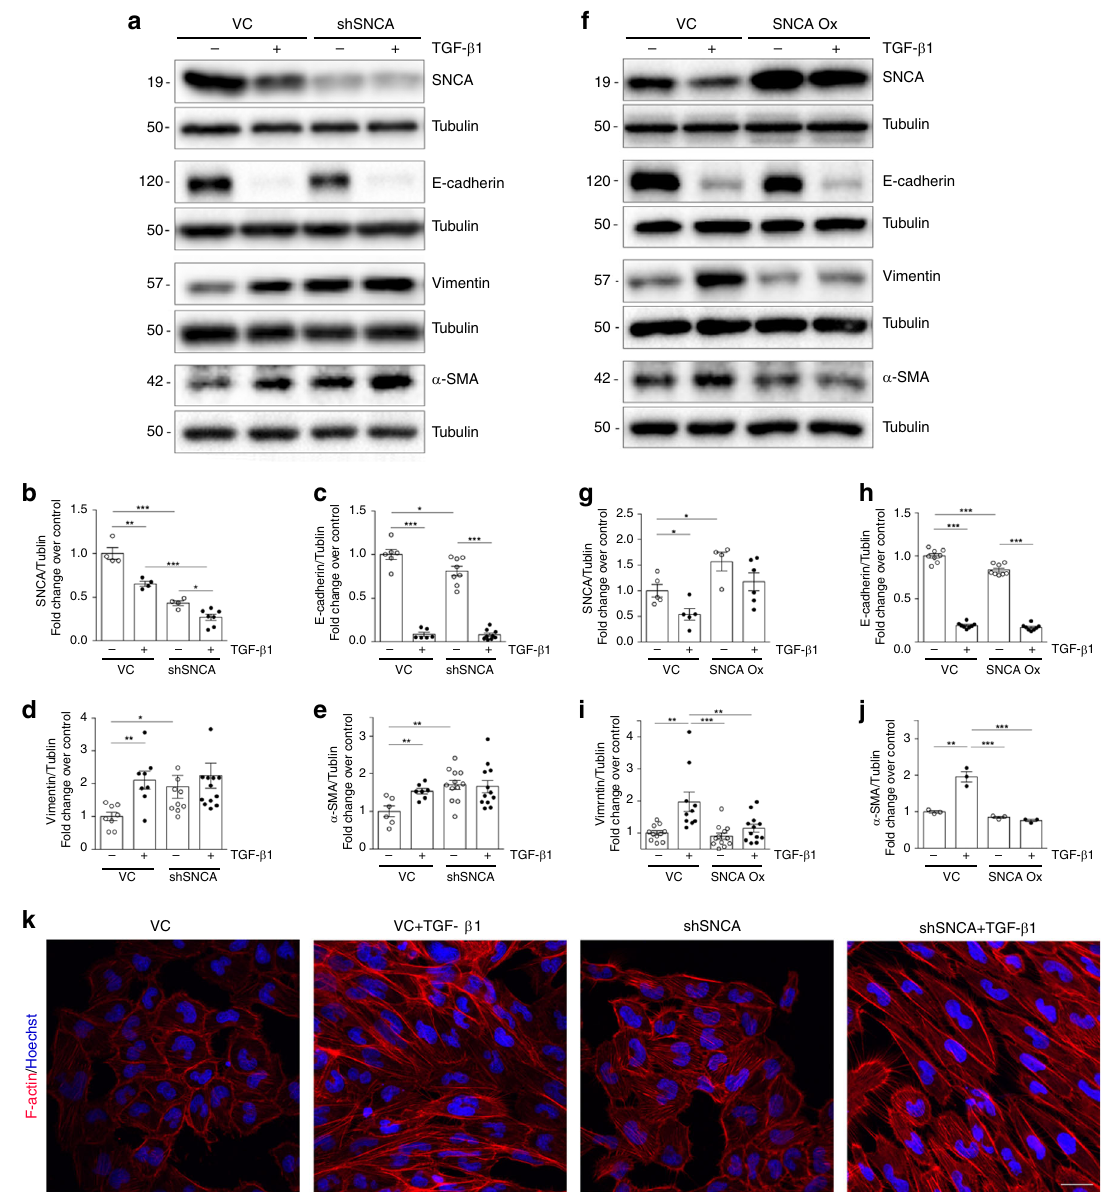
Fig. 2 SNCA modulates the epithelial phenotype in vitro. HK-2 cells (VC, shSNCA or SNCA Ox) were incubated with serum-free medium or treated with TGF- β 1 (2 ng/ml) for 72 h. a , f Cell lysates were immunoblotted with antibodies against E-cadherin, SNCA, vimentin, and α -SMA. The same samples were reprobed with antibodies against tubulin to ensure equal loading. Representative Western blots ( a , f ) and quantitative densitometric analysis ( b – j ) show expression of SNCA, E-cadherin, α -SMA, and vimentin in VC and shSNCA cells ( a , b – e ) or VC and SNCA Ox cells ( f , g – j ) treated with TGF- β 1 for 72 h. Data are presented as mean ± SEM of at least n = 3 independent experiments. k F-actin staining for the detection of actin fi laments in HK-2 cells. Cells were incubated with serum-free medium or treated with TGF- β 1 (2 ng/ml) for 24 h. F-actin was labeled with Phalloidin Alexa Fluor 568 (red). Nuclei were counterstained with Hoechst (blue). Scale bar represents 20 µ m. * p < 0.05, ** p < 0.01, *** p < 0.001. The p-value by two-way ANOVA. VC — control vector; shSNCA — cells with SNCA downregulation; SNCA Ox — cells overexpressing SNCA. Source data are provided as a Source Data fi